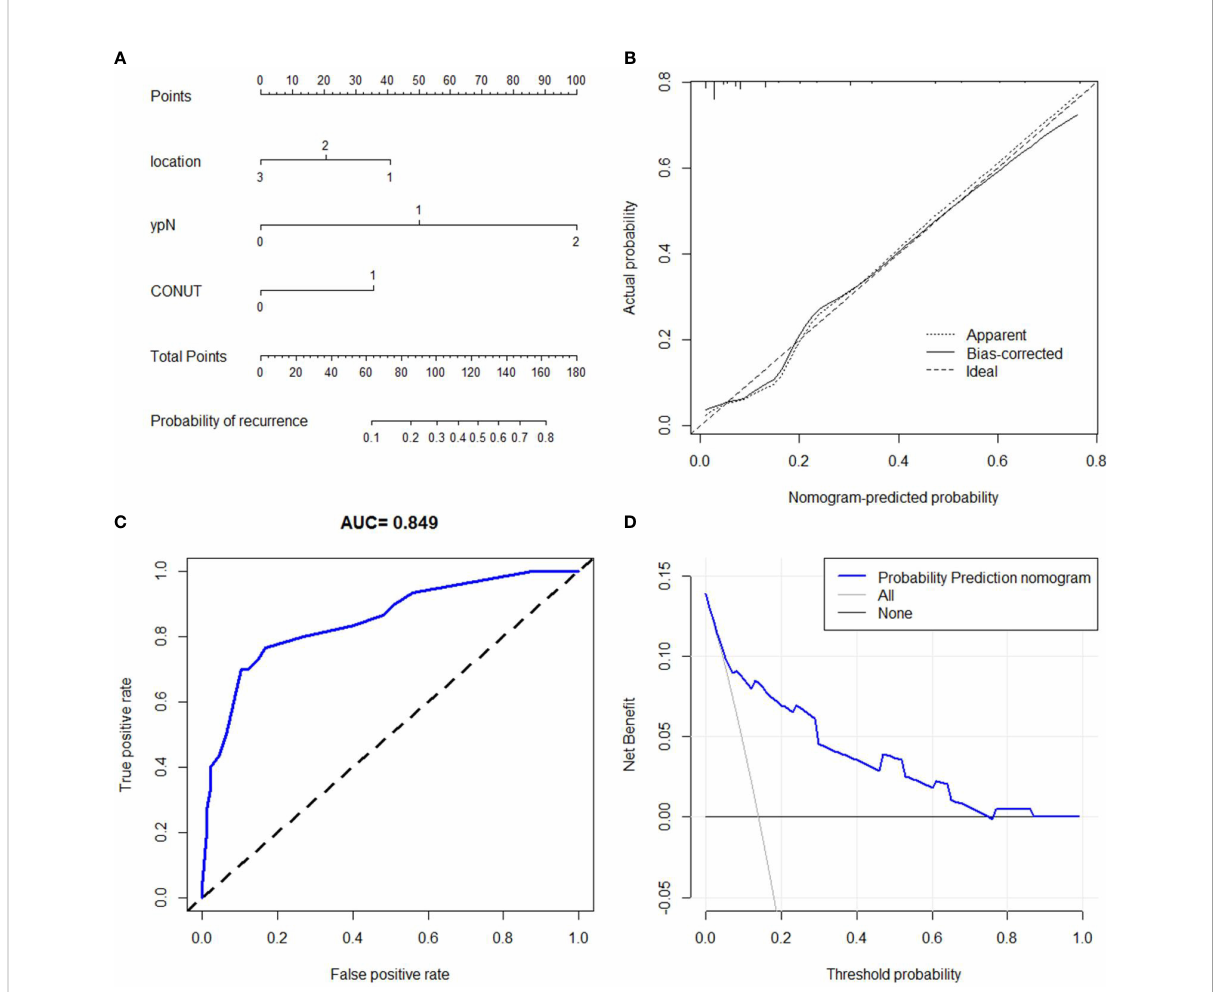
FIGURE 7 Nomogram for recurrence prediction. A predictive nomogram with the C-index of 0.846 was established (A) . The calibration revealed an acceptable agreement of recurrence prediction internally (B) . Receiver operating characteristic (C) and decision curve analyses (D) indicated a good clinical applicability of the model in predicting